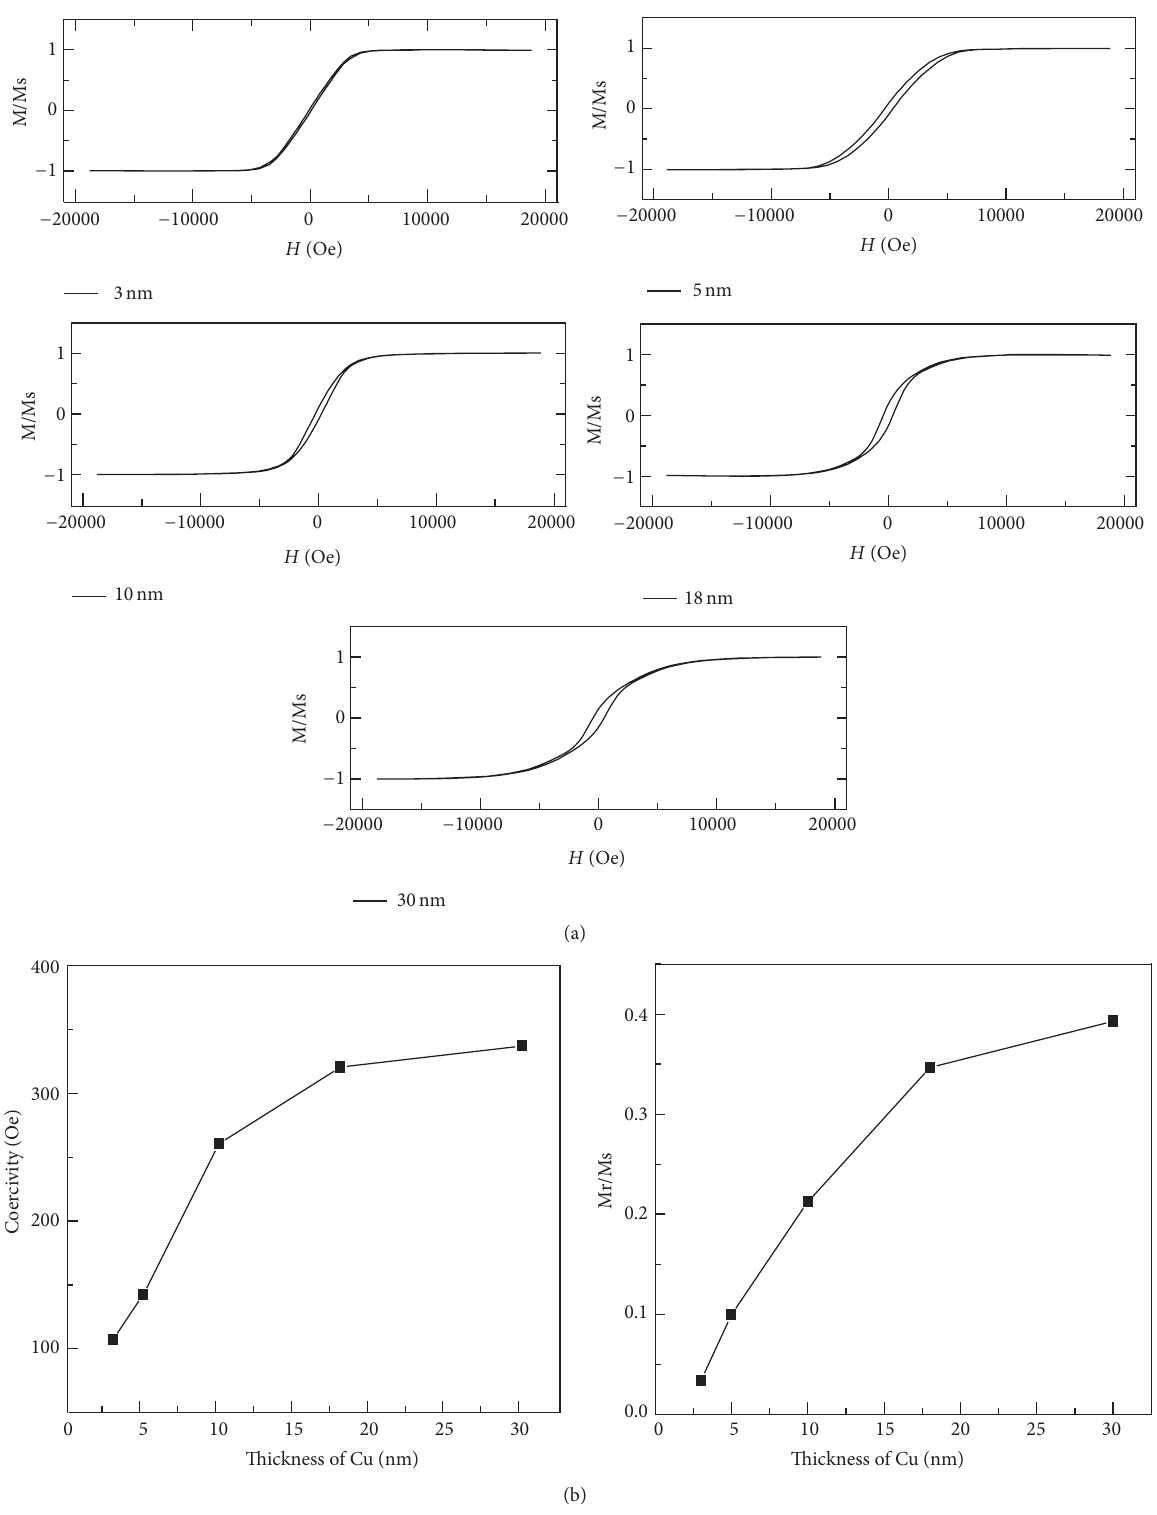
Figure 4: (a) Magnetic hysteresis loops of the Co/Cu nanowires with Co (50 nm) and Cu varied from 3 nm to 30 nm. (b) Evolution of the coercivity ( 𝐻 c ) and remanence ratio (Mr/Ms) with the change of Cu layer thickness under applied magnetic field parallel to the